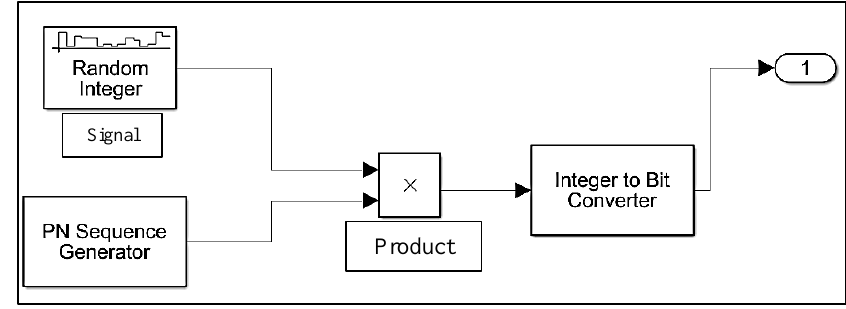
Figure 5. Data source for the CDMA